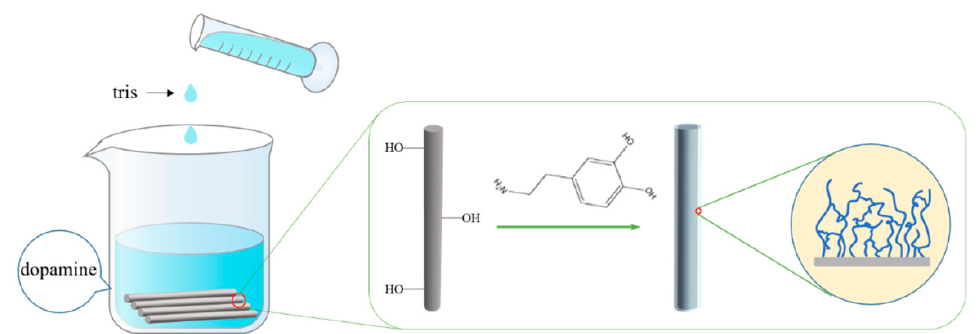
Figure 2. Mechanism diagram of PDA modified BF.